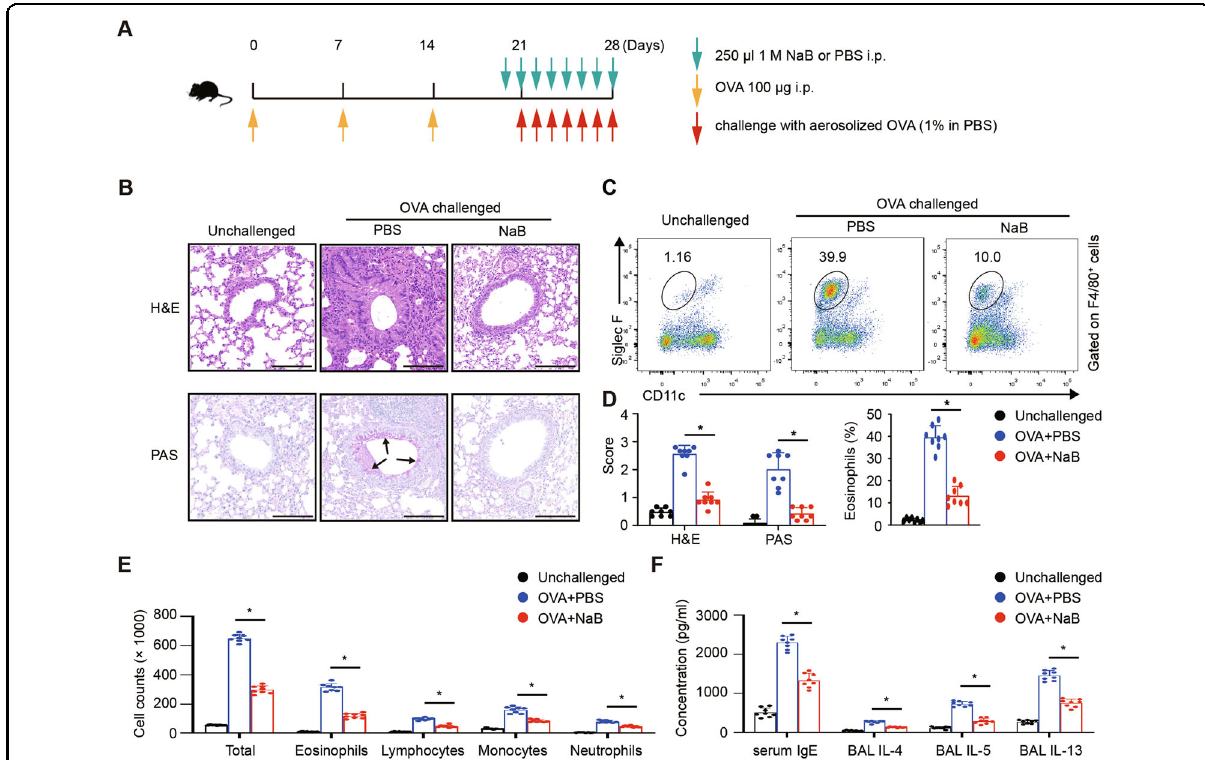
Fig. 3 NaB ameliorates allergic airway in fl ammation in vivo. A Schematic representation of the OVA-induced acute allergic lung in fl ammation model. B Representative lung histology sections displaying in fl ammatory cell in fi ltration and PAS + mucin-secreting cell hyperplasia. The arrow indicates purple-red mucin-producing cells. Bars, 100 µm. C Gate in color FACS plots identifying in fi ltrated eosinophils (CD45 + F4/80 + Siglec F + CD11c − ) in the lungs. D The graph displays the histological scores determined by H&E and PAS staining. Five areas were randomly chosen in each slide. The percentages of eosinophils among F4/80 + lung in fi ltrated cells are displayed in the histograms. E Different cell counts in the BAL fl uid. F Total IgE levels in the blood serum and IL-4, IL-5, and IL-13 levels in the BAL fl uid, as determined by ELISA. Data are the mean ± SD and representative of three independent experiments. Each group included eight mice. * p <